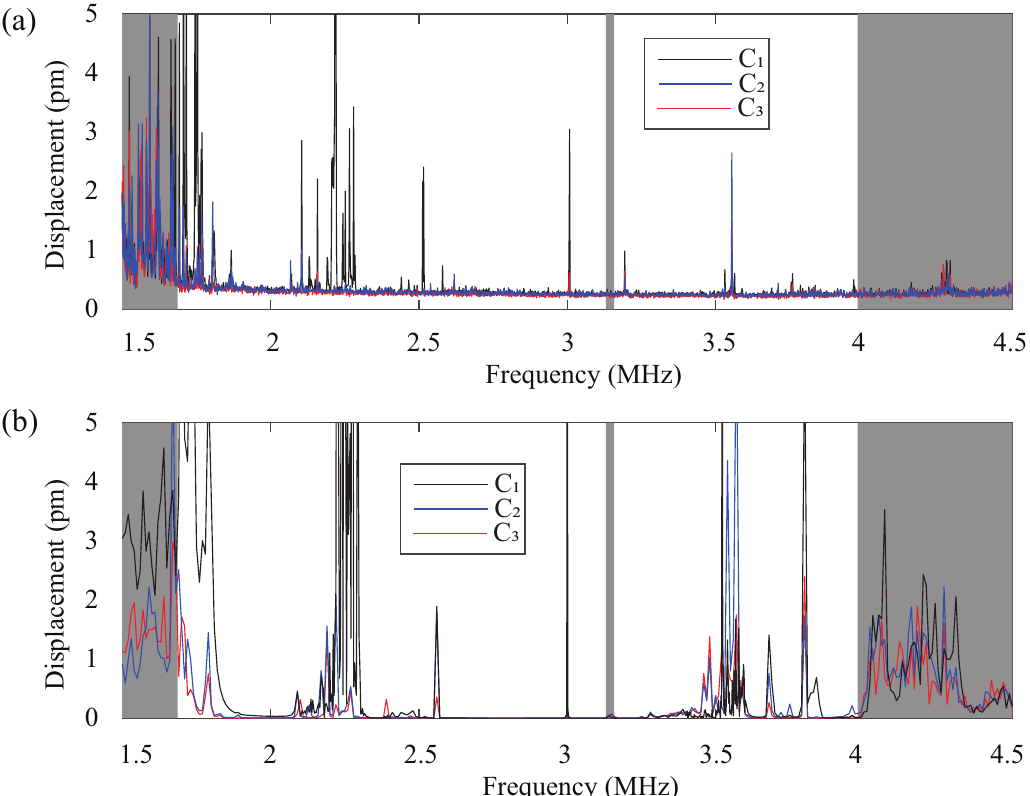
Figure 3. ( a ) Experimental and ( b ) numerical absolute vertical displacement at the position of the received